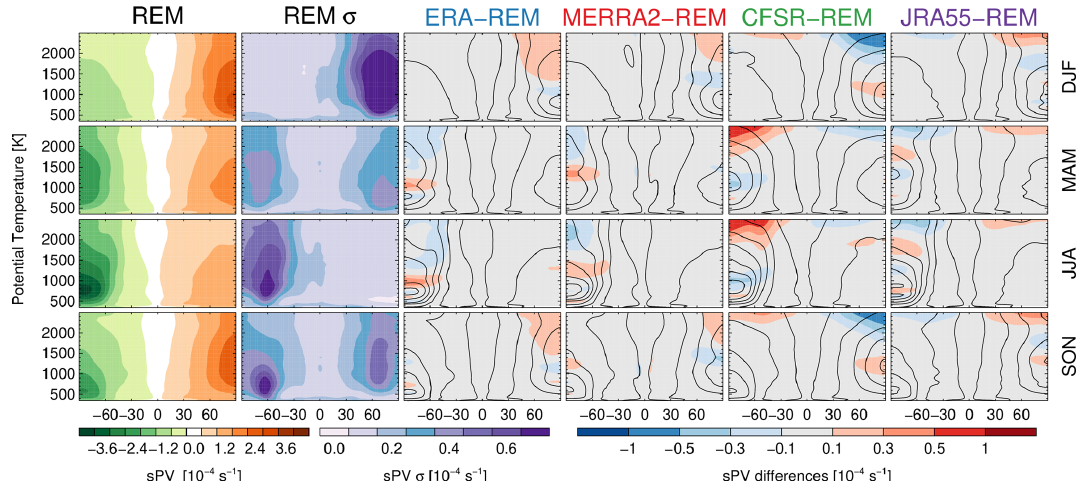
Figure 3. sPV REM seasonal climatological mean and standard deviation (left two columns). sPV difference between each reanalysis and the REM; line contours show each reanalyses’ seasonal climatology (right columns).